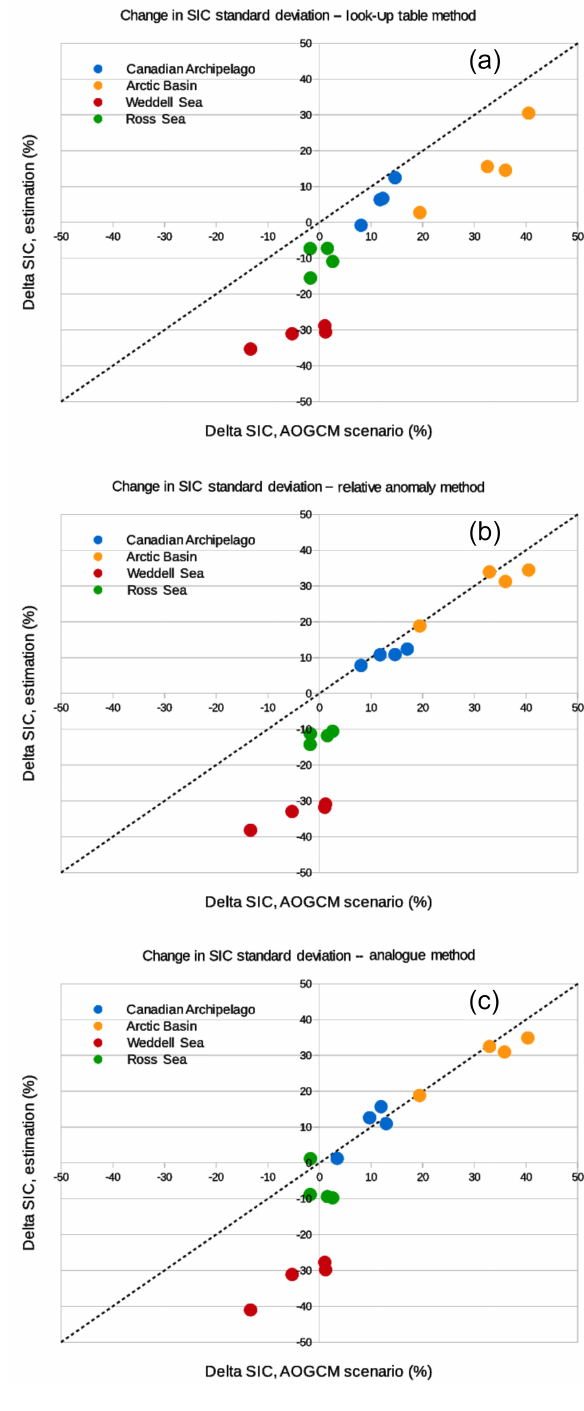
Figure 8. Change in bias-corrected SIC projection standard devi- ation using (a) look-up table, (b) iterative relative anomaly and (c) analogue methods against corresponding mean change in the AOGCM projection for the four test regions: Canadian Archipelago (blue), Arctic Basin (orange), Weddell Sea (red) and Ross Sea (green) for projections from CNRM-CM5 and